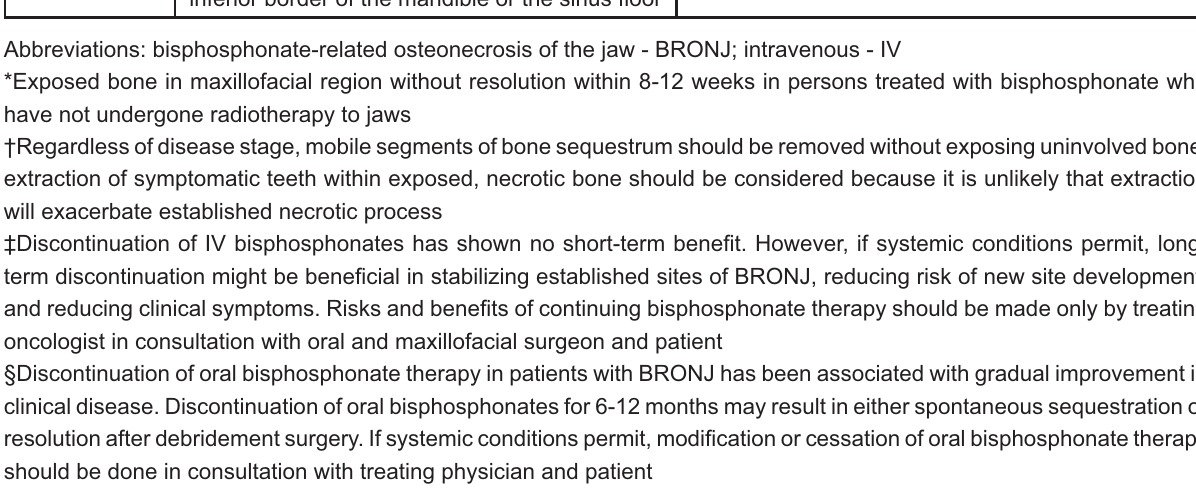
Figure 2- Staging and treatment strategies. [Ruggiero, et al.